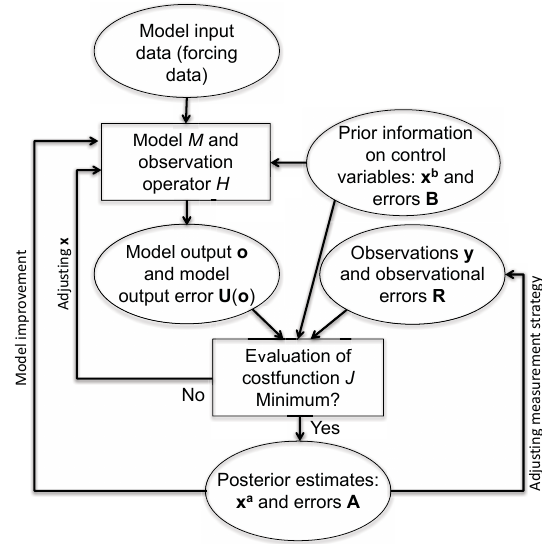
Figure 1. Schematic of a data assimilation system with x being the control vector containing the quantities to be updated by the assim- ilation. The loop between the “evaluation of J ” box to the “model and observation operator” box indicates the assimilation process (assimilation loop). Often, the analysis of residuals in model-data comparison leads to either model improvements or adjustment of the measurement strategies (“model improvement” and “adjusting measurement strategy”